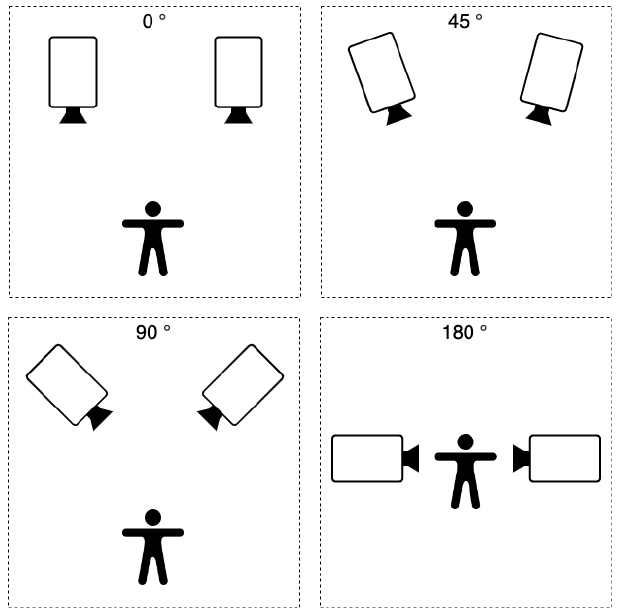
Figure 7. Multiple setups used for testing. Angles between cameras were: 0, 45, 90 and 180 rotation degree. Distances between cameras were 1 and 1.6